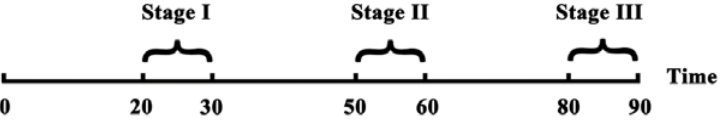
Figure 3. Driving segments. Figure 3. Driving